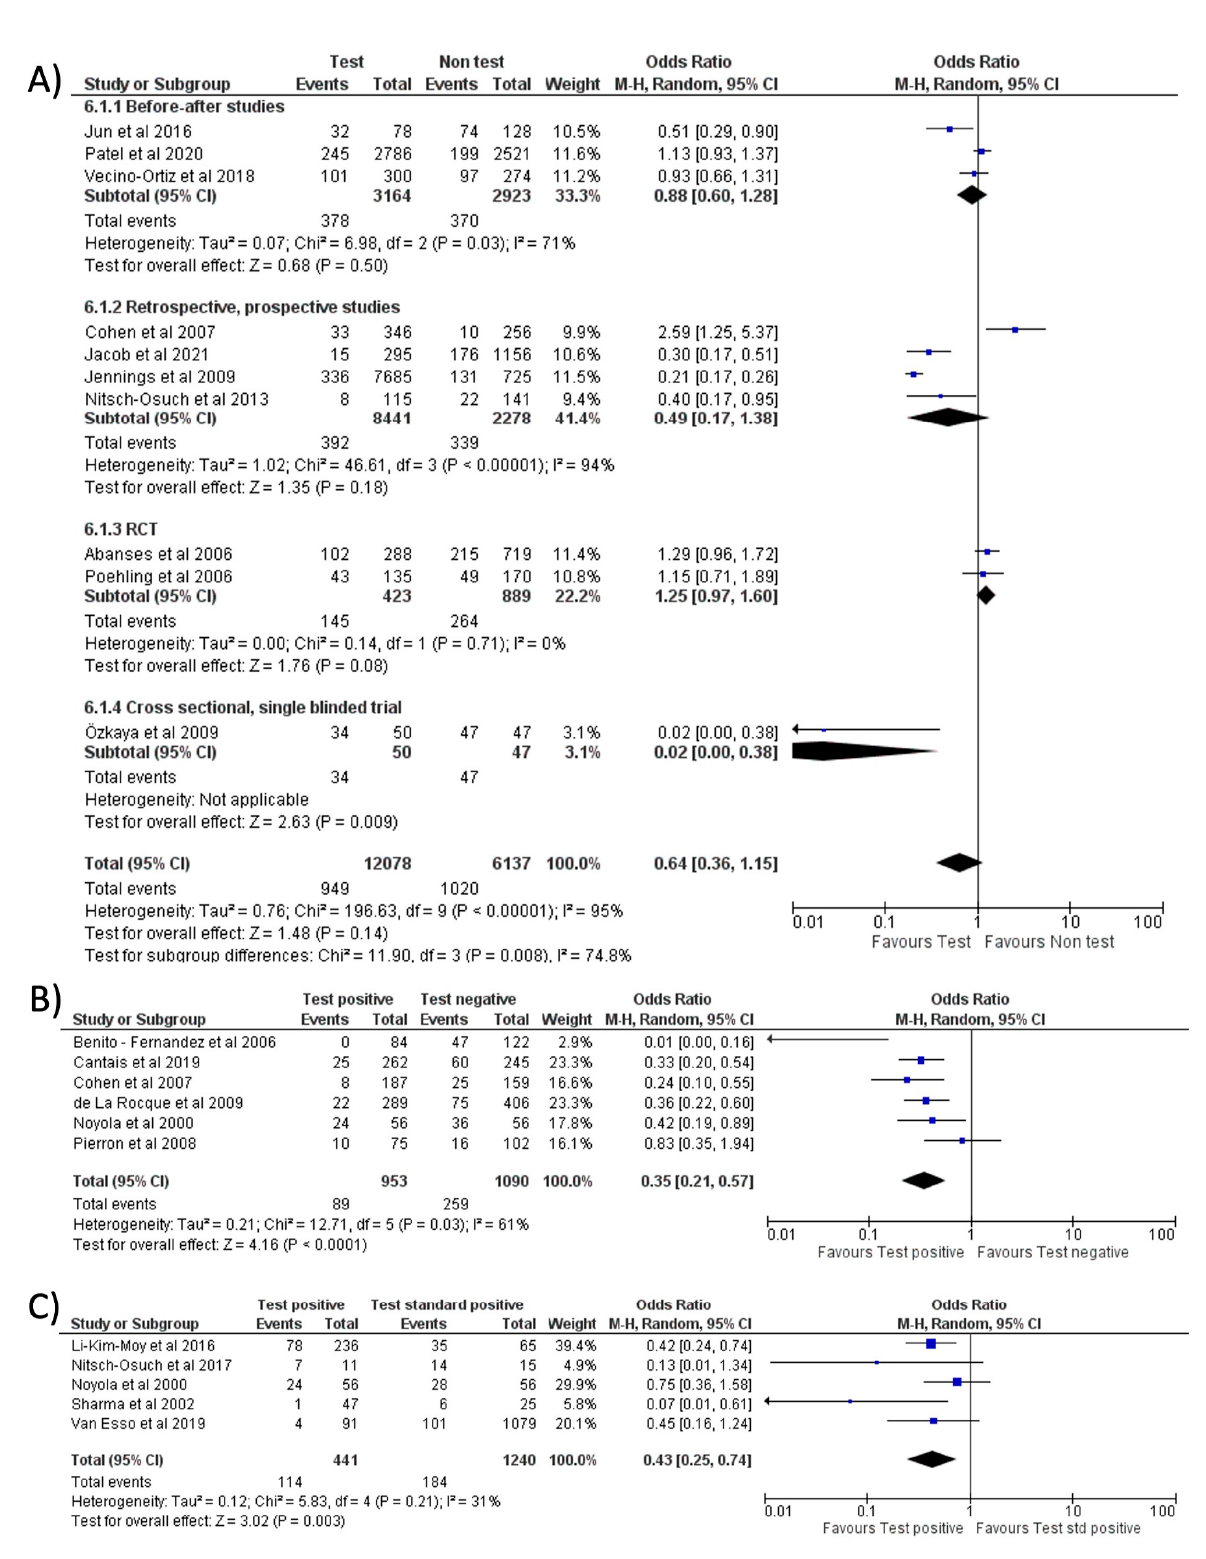
Figure 5. Forest plot of prescription of antibiotics after implementation of RIDT: ( A ) RIDT vs. clinical diagnosis; ( B ) RIDT positive versus RIDT negative; ( C ) RIDT positive vs. standard of care